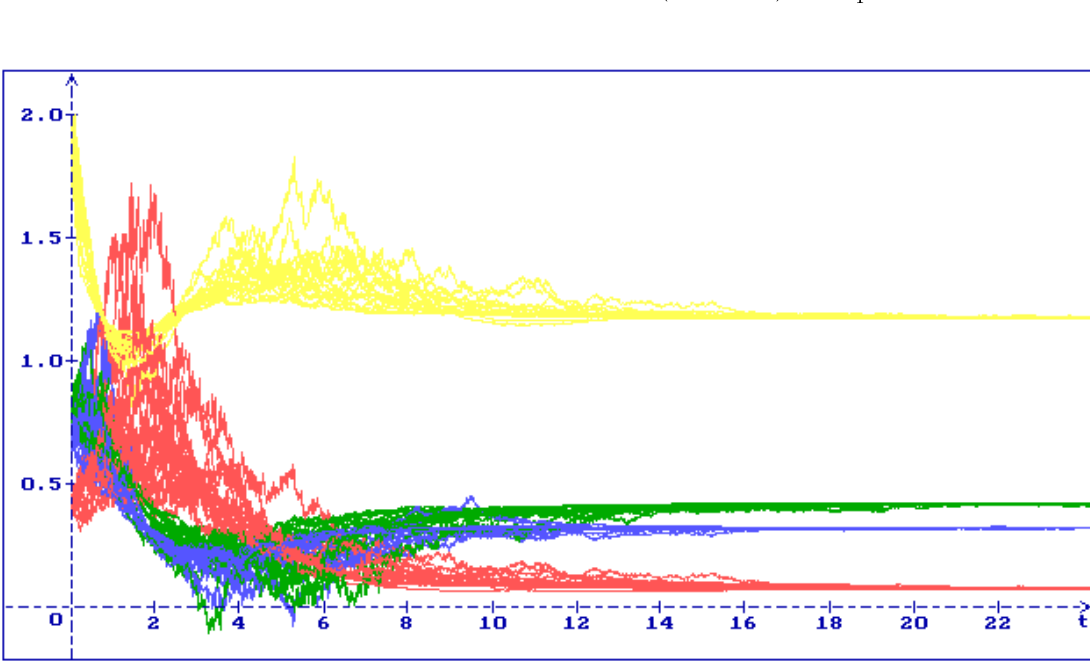
Figure 5. 30 trajectories of the system (6) solution with the initial condition I ( 0 ) = 1.9, S 1 ( 0 ) = 0.8, S 2 ( 0 ) = 0.7, R ( 0 ) = 0.4: all trajectories I ( t ) (yellow), S 1 ( t ) (green), S 2 ( t ) (blue), R ( t ) (red) converge to the equilibrium E 4 = ( I ∗ , S ∗ , S ∗ , R ∗ ) = ( 1.1765,0.4250,0.3250,0.0735 ) 2 1